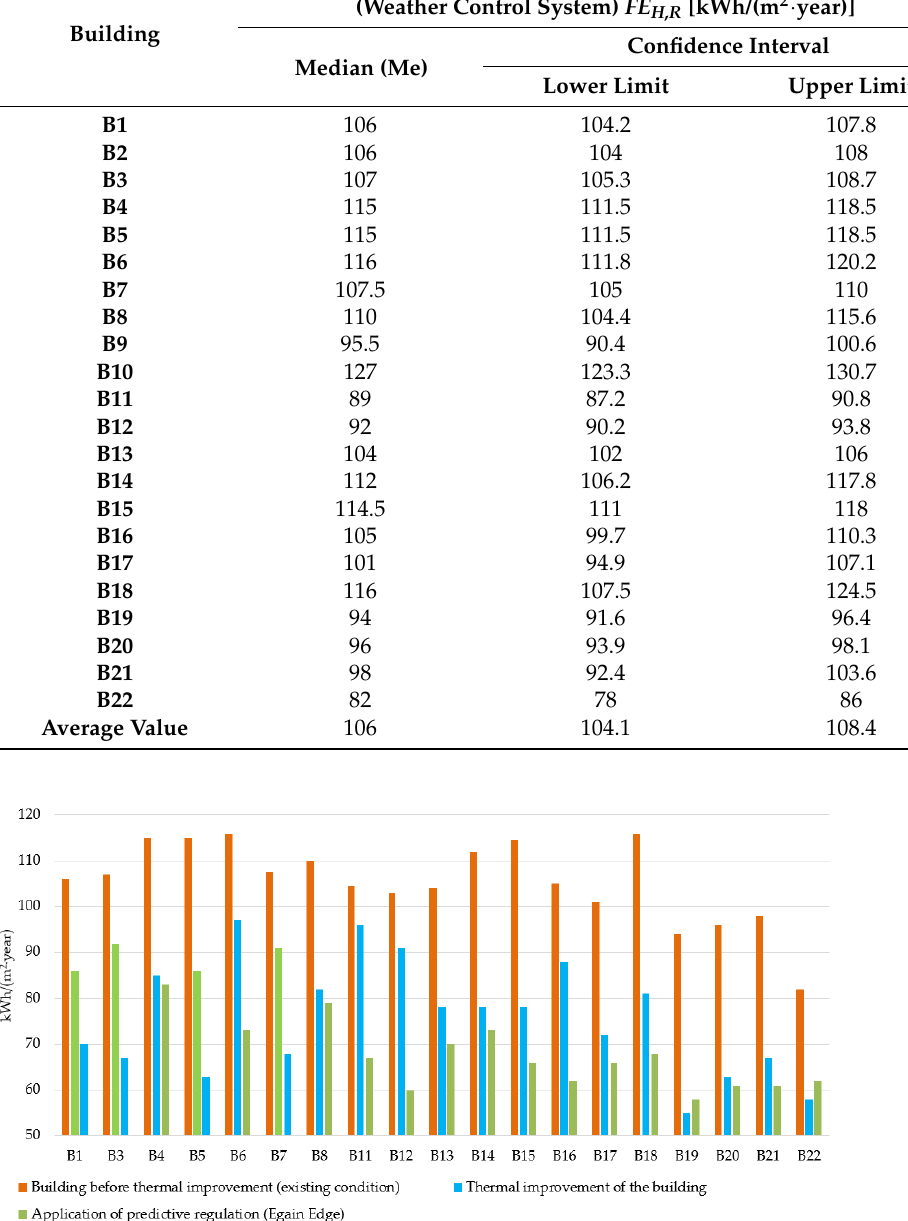
Figure 7. Change in energy consumption for heating purposes after the introduction of the individual variants.